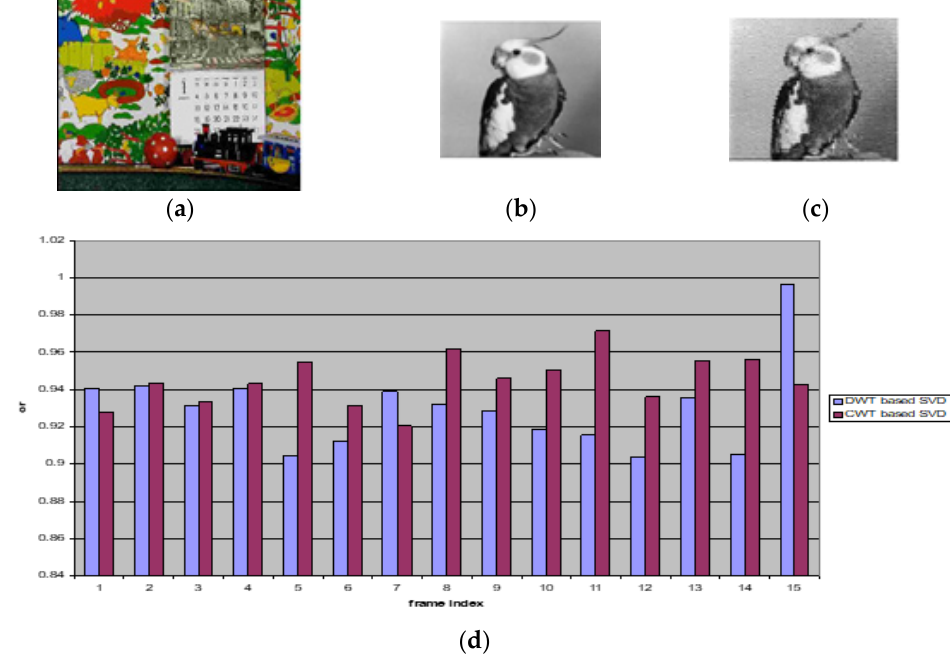
Figure 13. ( a ) The watermarked frame under compression attack using the proposed method. ( b ) Extracted watermark from frame 10 of the first video scene in the proposed method. ( c ) Extracted watermark from frame 10 of the first video scene for the DWT-based SVD method. ( d ) Correlation values for the extracted watermarks for frames 1 to 15 in the first video scene under compression attack.